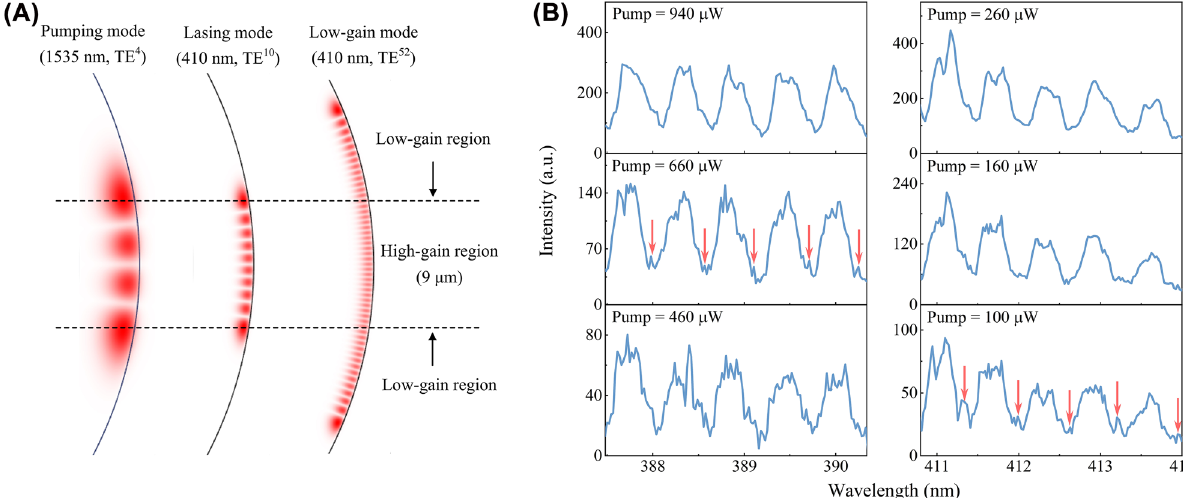
Figure 3: Annihilation of Purcell-enhanced spontaneous peaks. (A) Electric field intensity distributions of the pumping, lasing and low-gain modes on the cross-plane of the microsphere along the axis direction, where the superscript represents the axial quantum number and the dash lines are located at the maximum electric field intensities of the pumping mode. (B) Detailed lasing spectrum evolution with the increased pump power, where the red arrows with a spacing of one FSR point to typical Purcell-enhanced spontaneous